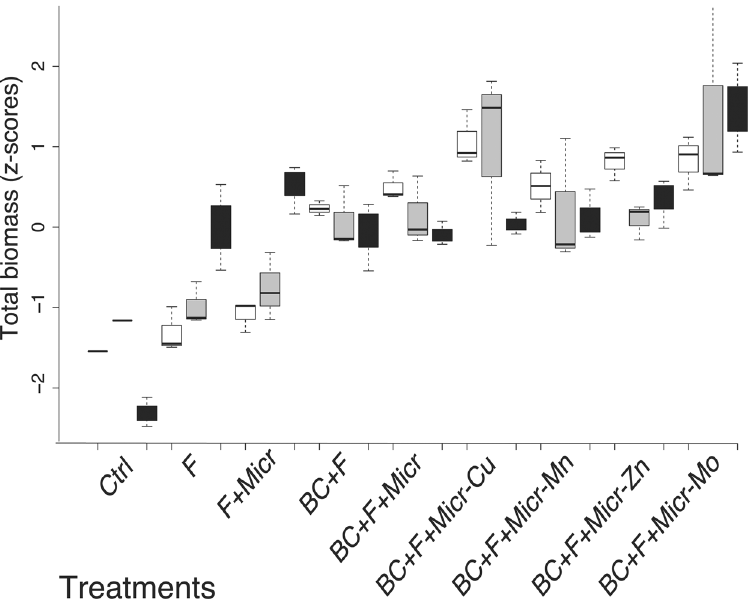
Figure 2: Total biomass yield; data standardized as z - scores, calculated separately for each year: white = beet 2016, gray = beet 2017, and black = wheat 2018.